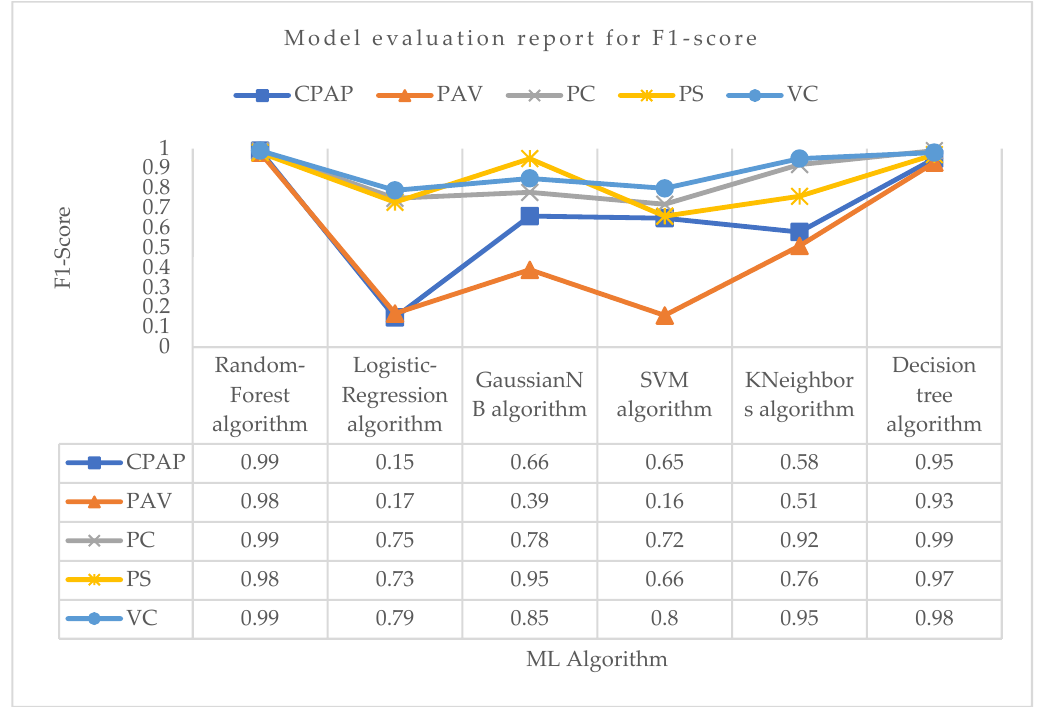
Figure 10. Model evaluation report of F1 score for different modes and ML